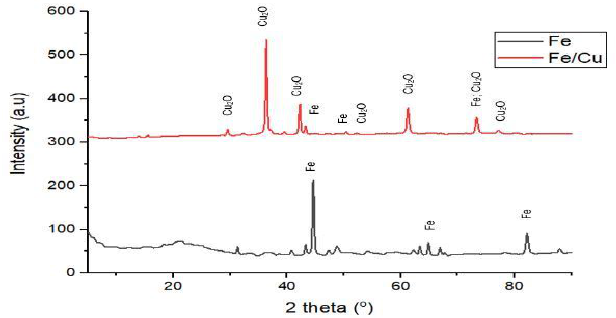
Figure 5. XRD spectrums of Fe and Fe-Cu